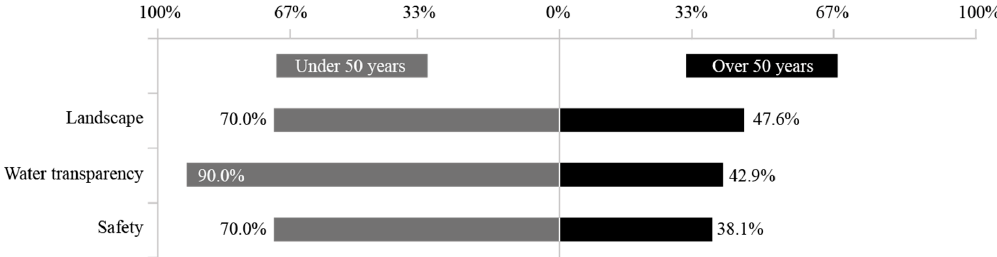
Figure 7. Ratio of Answers “no change in the Fukushima-gata lagoon before and after the reclamation project” (n = 31).